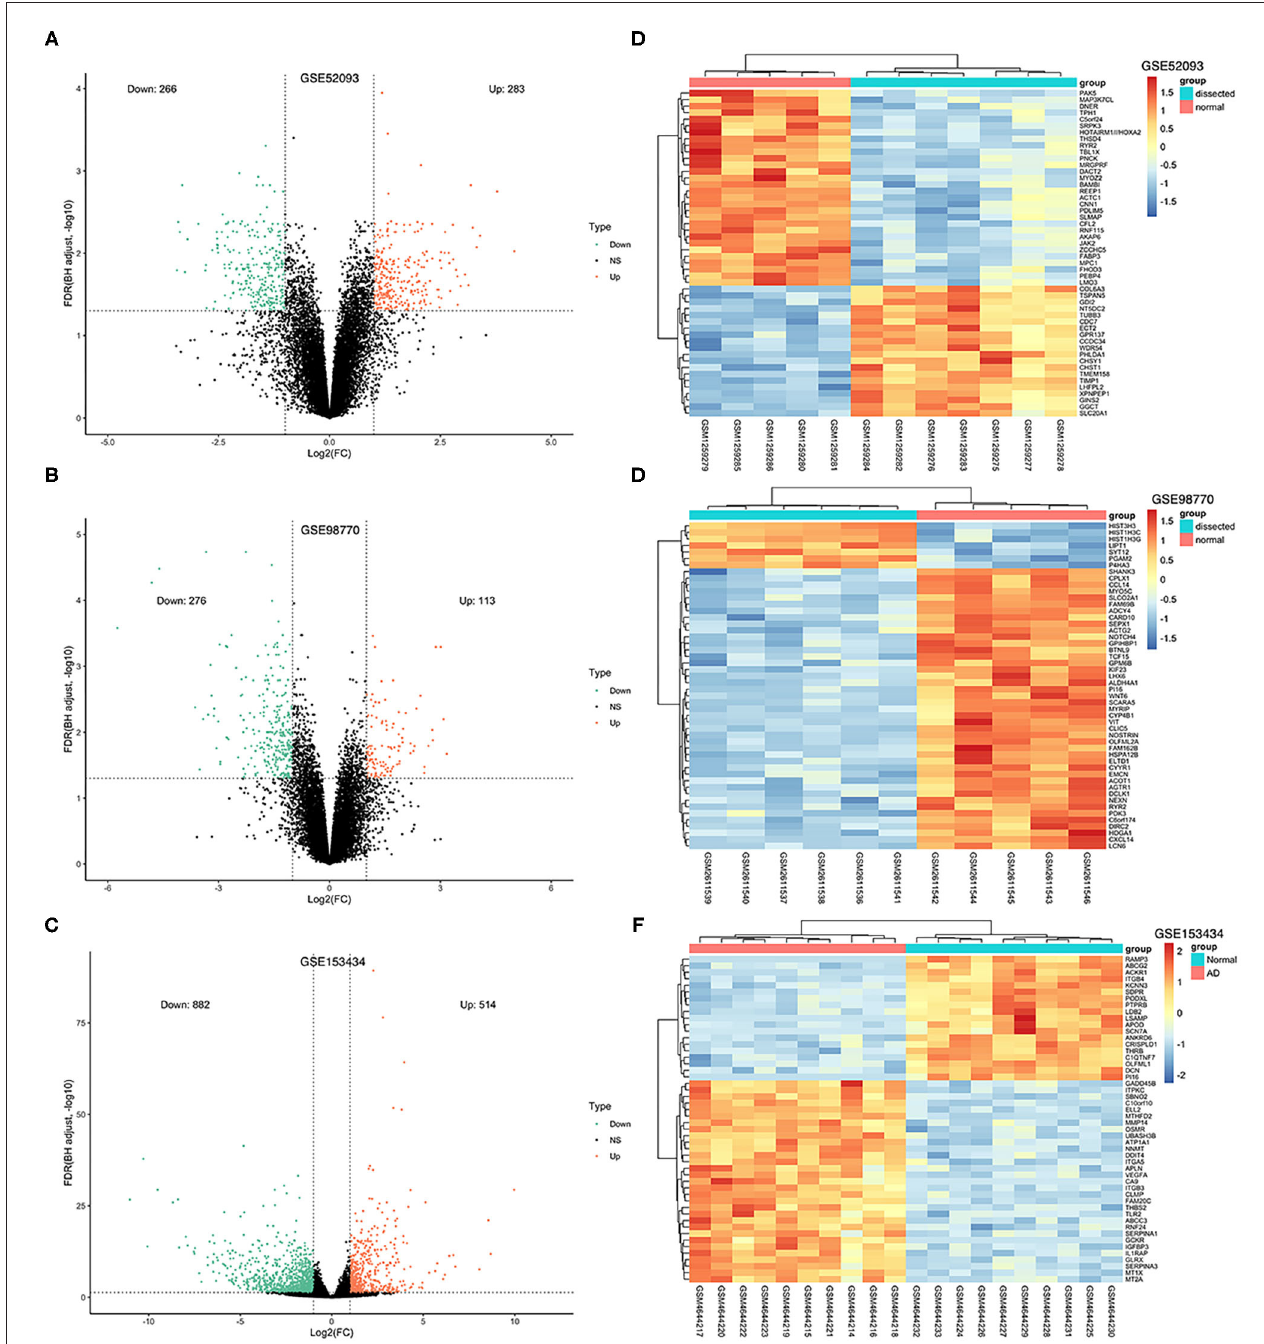
FIGURE 2 | Volcano plots and heatmaps of DEGs from the three datasets. (A–C) Volcano plots of DEGs from GSE52093, GSE98770 and GSE153434. The red dots represent upregulated differential genes, the green dots represent differential downregulated genes and the black dots represent genes without significant differences. (D–F) Heatmaps of the top 50 DEGs from GSE52093, GSE98770, and GSE153434. Red represents upregulated DEGs, blue represents downregulated DEGS, and the gradation of color represents the value of |log FC|.